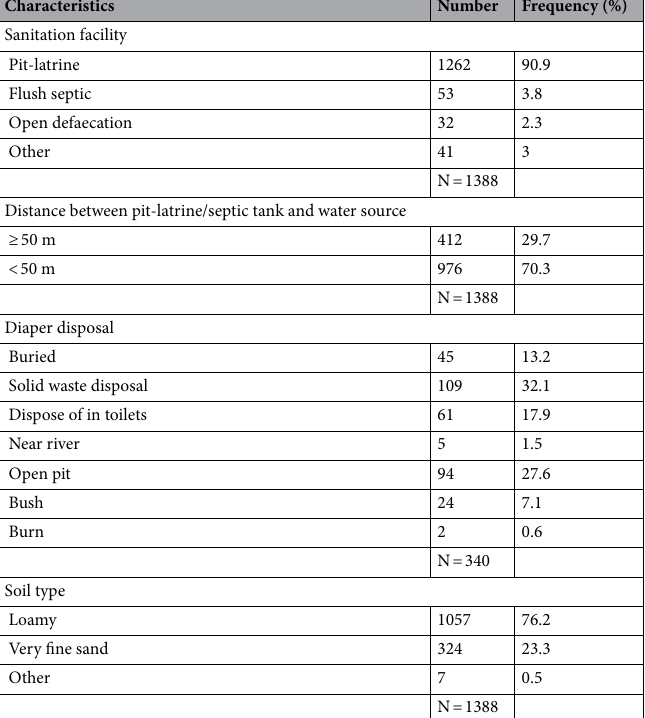
Table 3. Sanitation-related status in the study area.